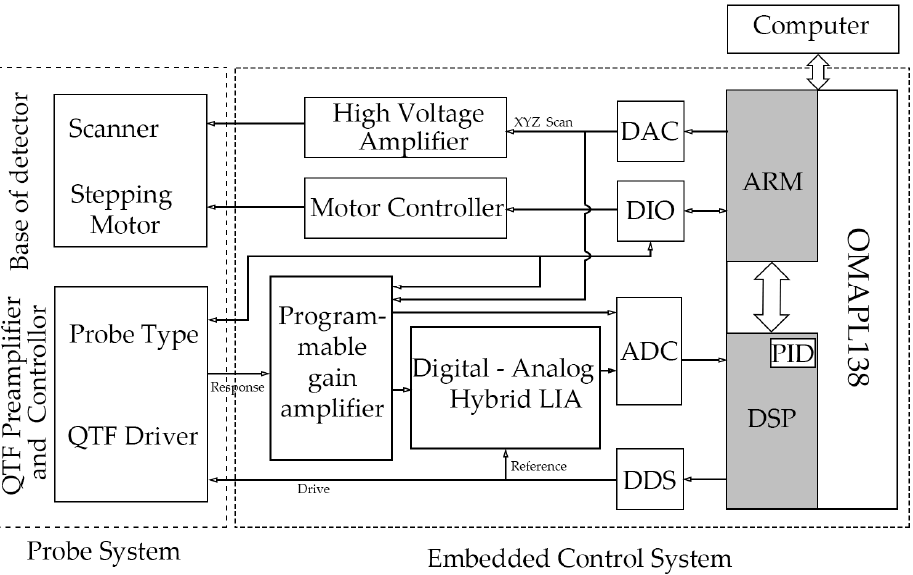
Figure 1. Schematic diagram of the AFM control system based on the QTF self-induction probe and the whole instrument.